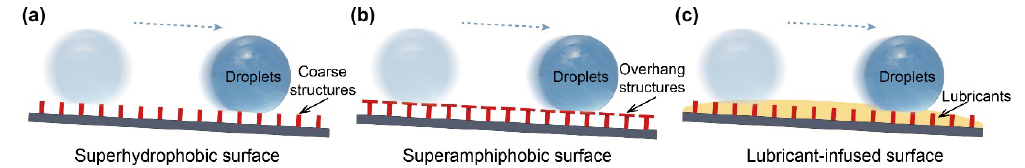
Fig. 2 Sketch map of three typical superslippery surfaces: (a) superhydrophobic surfaces, (b) superamphiphobic surfaces, and (c) lubricant-infused